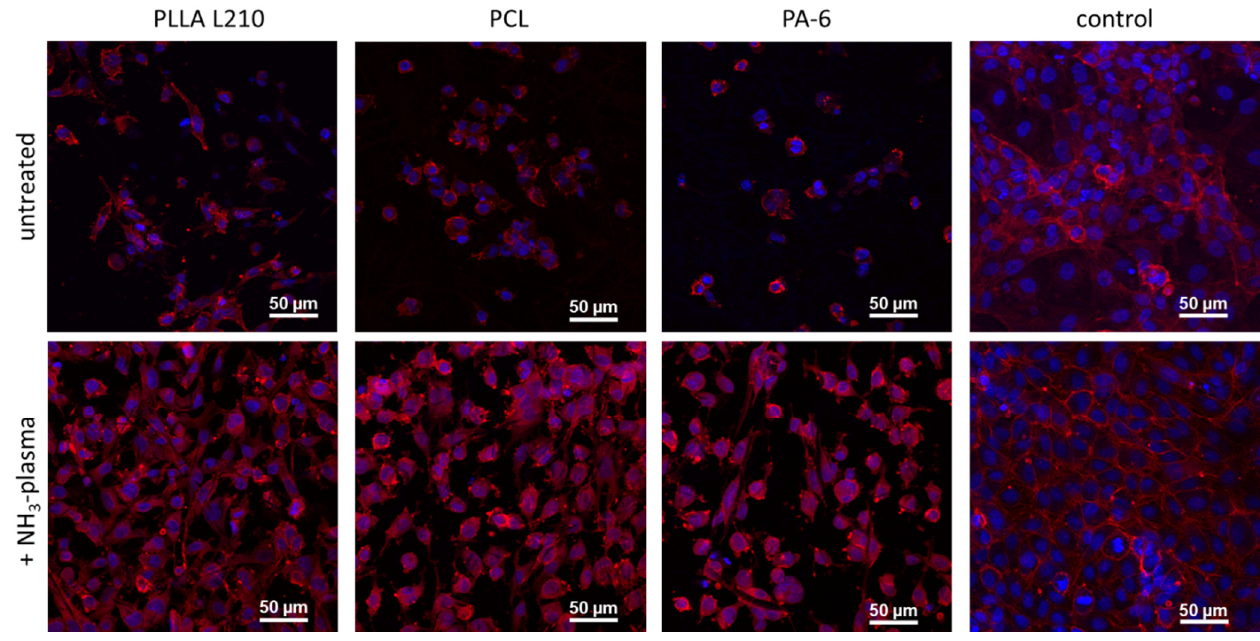
Figure 10. Fluorescent staining of F-actin in human endothelial EA.hy926 cells grown for 48 h on untreated and NH 3 -plasma functionalized polymeric nonwovens (red: phalloidin-TRITC for F-actin, blue: Hoechst-staining indicating cell nuclei, confocal microscopy, and bar = 50 µm).